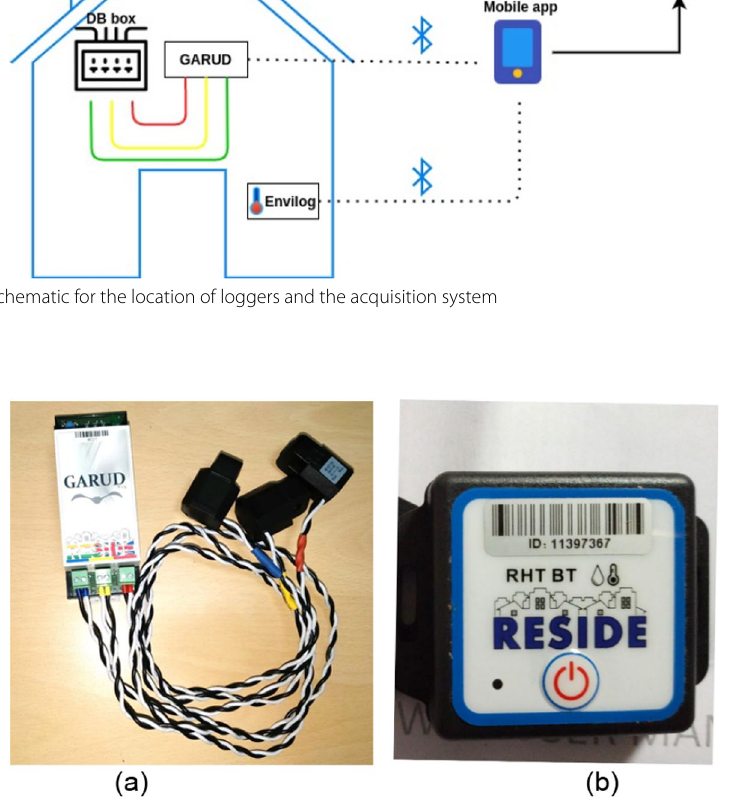
Fig. 2 Garud and EnviLog loggers used to capture